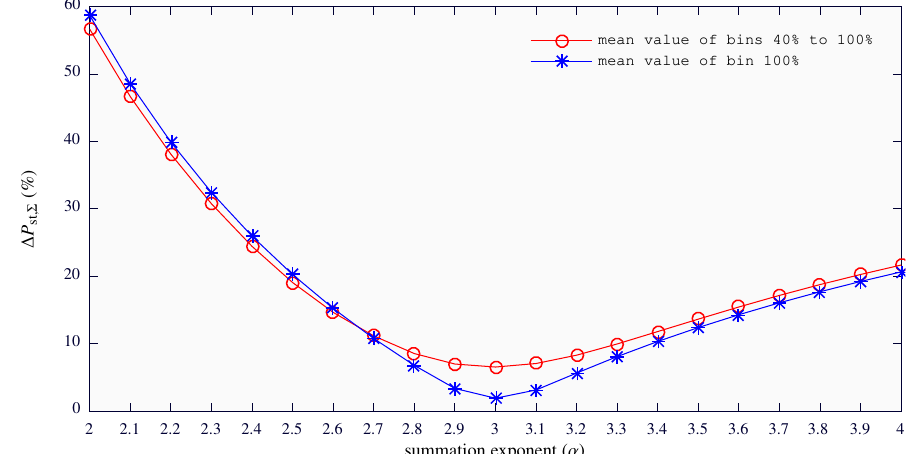
Figure 9. Mean of percentage deviations between the estimated P st, Σ and measured P st,L2 values with respect to α for the time series grouped between the 40% and 100% power bins (red circles), and for the time series grouped at 100% power bin (blue